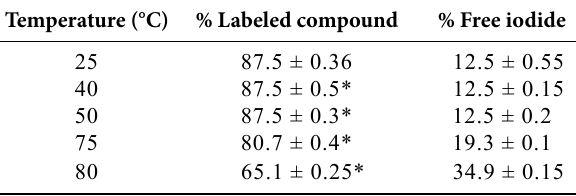
Table 8. Effect of reaction temperature on the % labeling yield of 125 I- TP 5